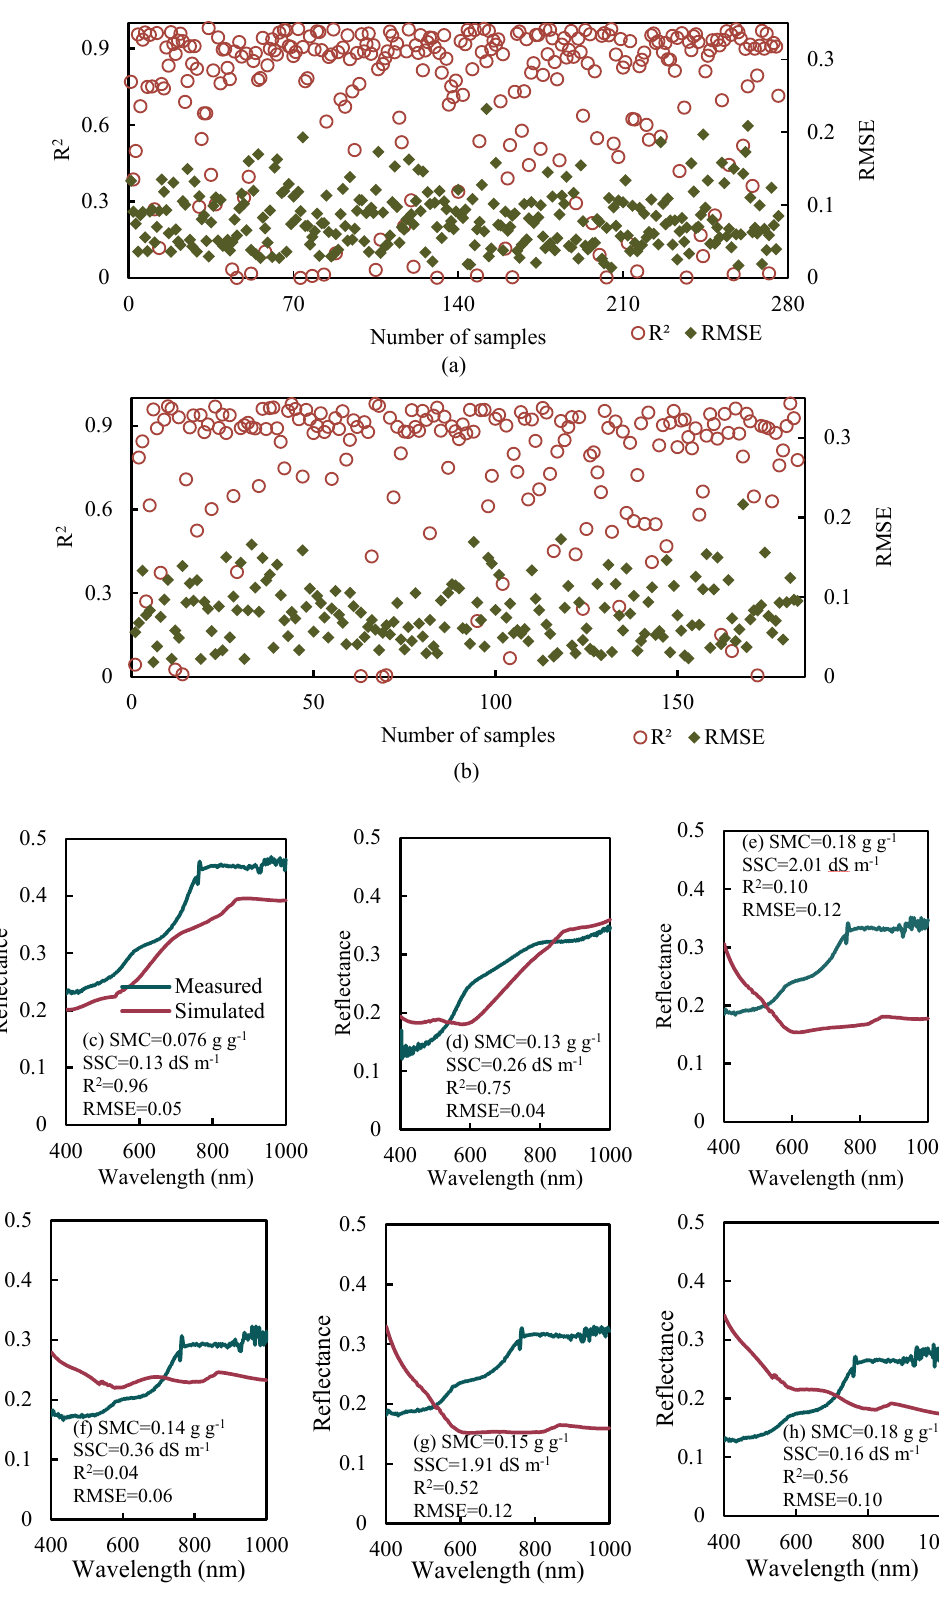
Figure 10. Comparison of simulated reflectance based on SSREM with measured reflectance: ( a ) simulation accuracy of calibration dataset; ( b ) simulation accuracy of validation dataset; ( c – e ) measurement and simulation of wet-soil reflectance from calibration dataset and ( f – h ) from validation dataset.